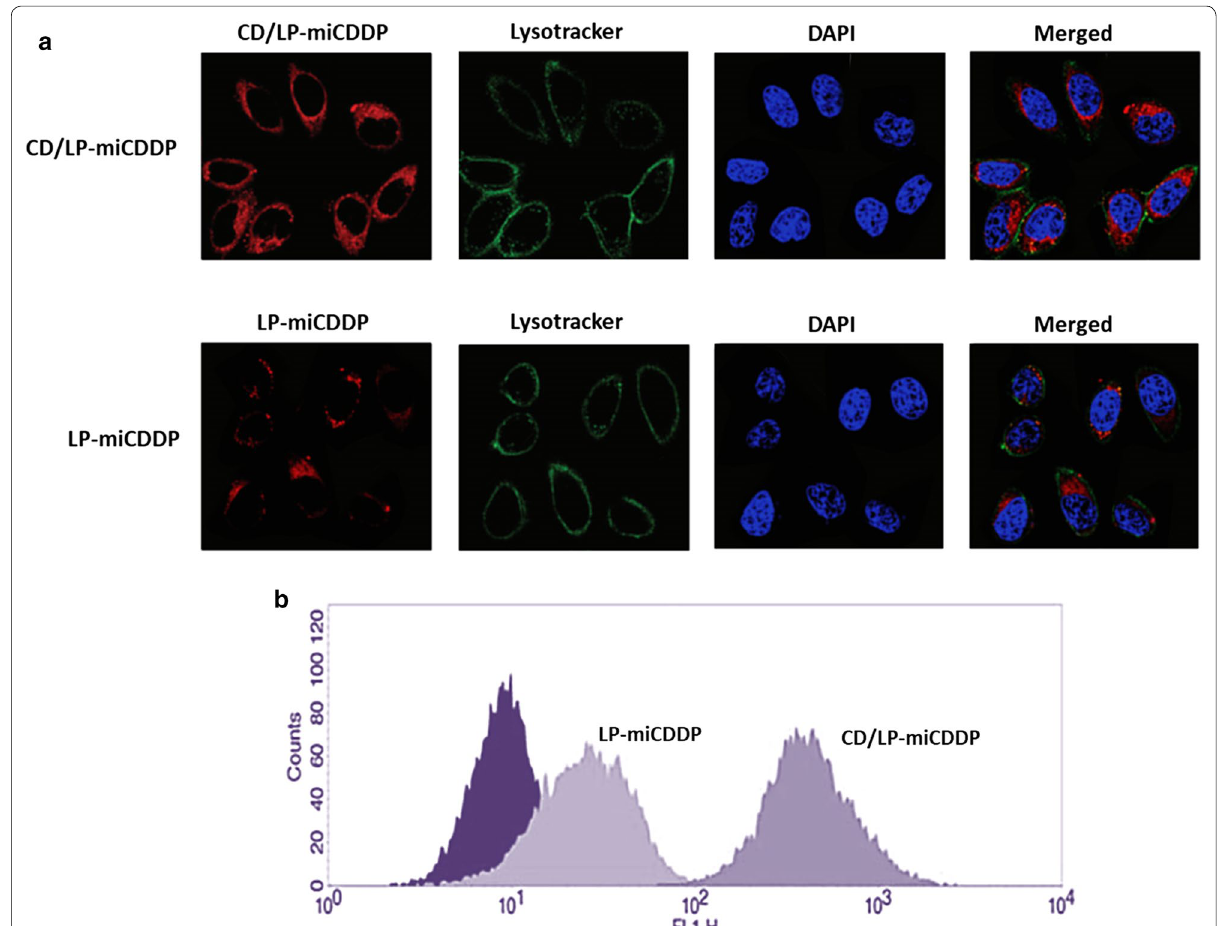
Fig. 4 a Cellular uptake analysis of LP‑miCDDP and CD/LP‑miCDDP in HeLa cells using confocal laser scanning microscopy (CLSM). The Rhodamine B was used as a fluorescent tracker and the cells were stained with Lysotracker Green and DAPI as a respective lysosome and nucleus tracker; b flow cytometer analysis of cellular uptake after incubation of liposomes to cells for 2